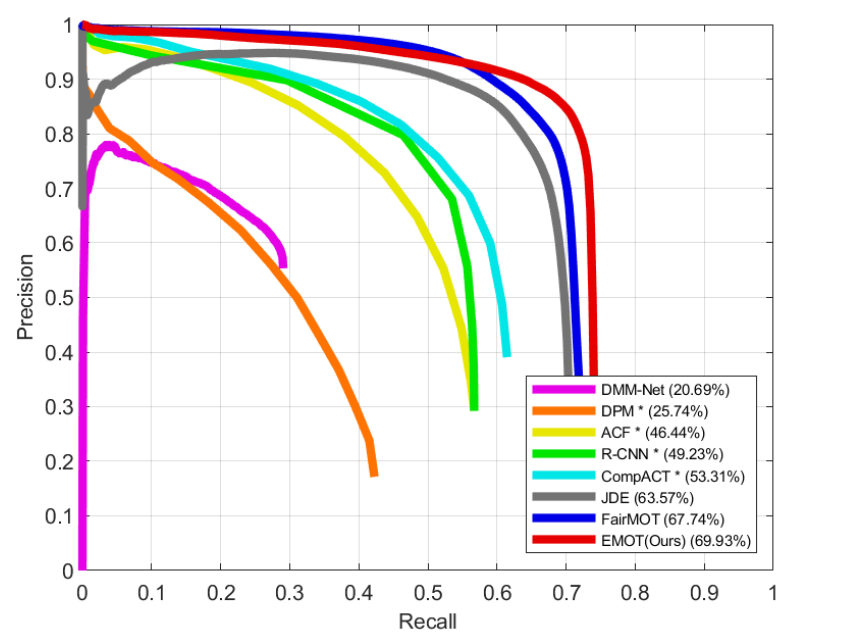
Figure 6. Precision-recall curves of our single-shot MOT system and different methods, which are evaluated on the UA-DETRAC-test set. The results of * were taken from Wen et al.